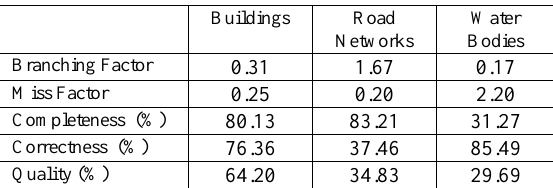
Table 3. Assessment result for different object features The road network has highest completeness (83.21%) while the water-bodies has highest correctness (85.49%) and highest quality is achieved by building layer (64.20%).